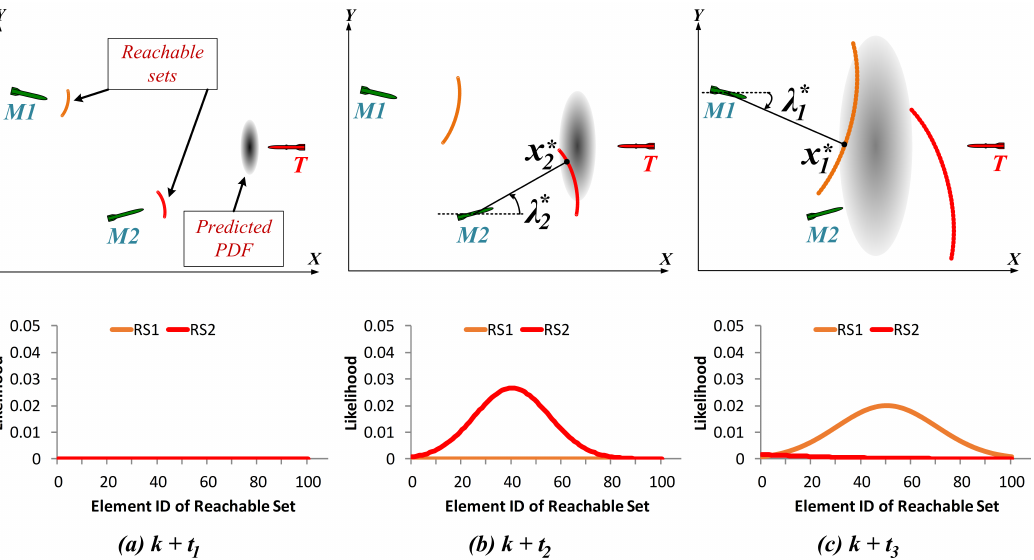
Figure 2. Illustration of reachable sets, corresponding likelihood, and pdf of predicted target state when time instants ( a ) k + t 1 , ( b ) k + t 2 , and ( c ) k + t